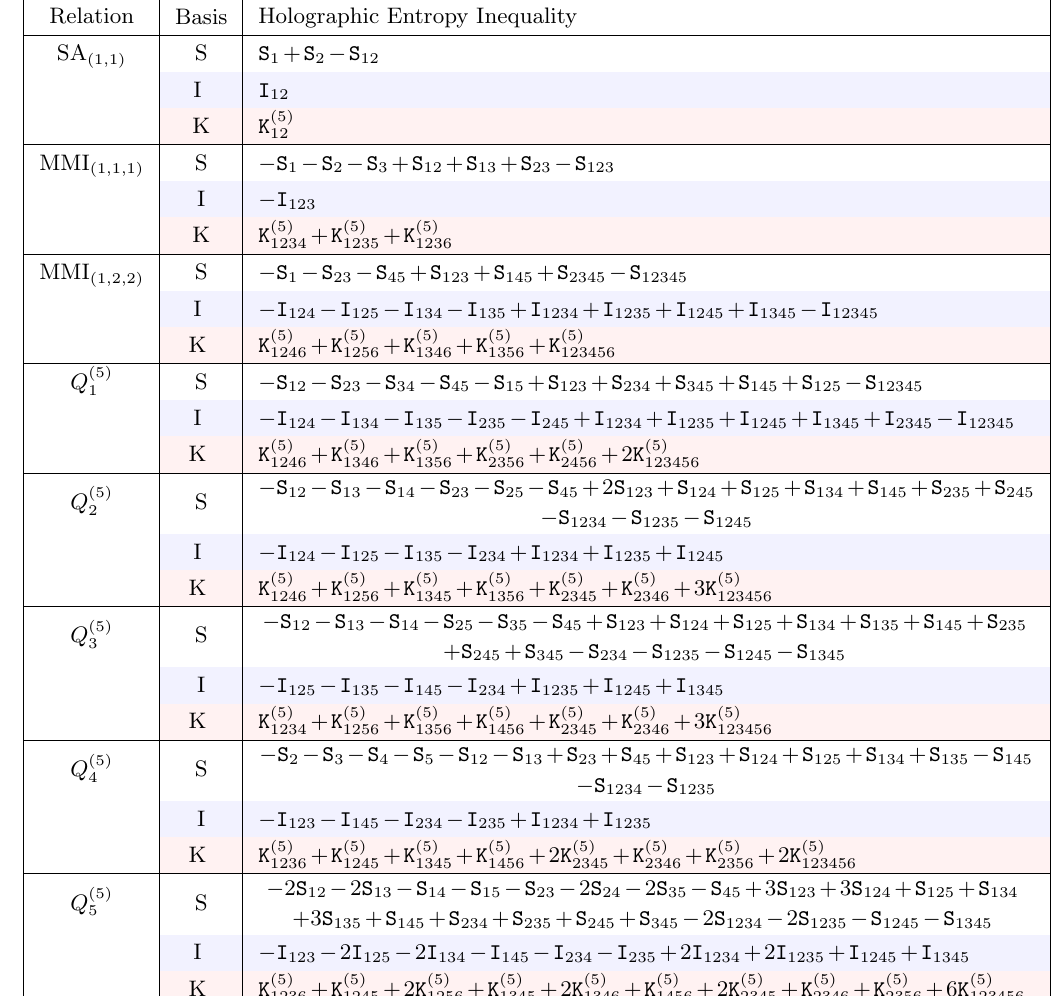
Table 1 . The non-redundant HEIs for N = 5 in the S, I, and K bases. The (cid:12)rst three rows are the standard SA and MMI (with the subscript corresponding to the cardinality of the arguments as in [11]), and the last (cid:12)ve rows are inequalities discovered in [5], and labeled simply as Q (5) since their deeper meaning is as yet obscure. Note that the coe(cid:14)cients of K (5) nonnegative, exemplifying a more general result of